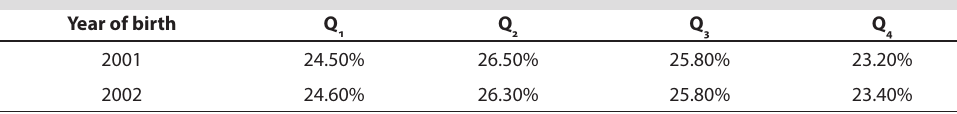
TABLE 1. Theoretical (Expected) Frequency of Hockey Players’ Birth Date (%)